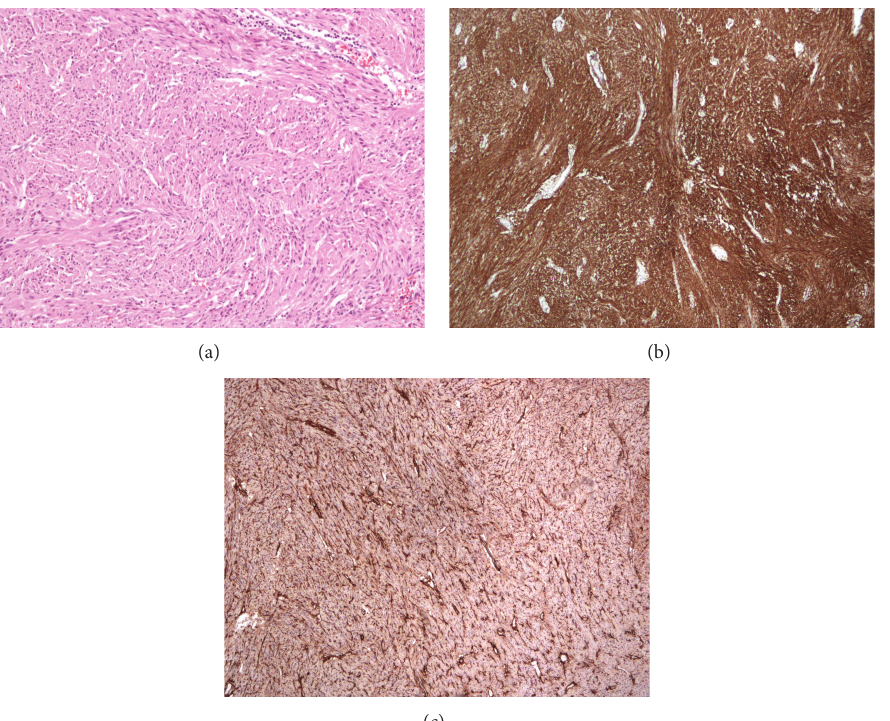
Figure 2: Immunohistochemistry at microscopic level of GIST neoplasm. (a) demonstrates the 10x image with hematoxylin and eosin staining. The tumour had a mitotic index of 2/50 high power fields (HPF). (b) shows positive staining for CD117 (c-kit) which is characteristic of GIST tumours and (c) shows the tumour also staining positive for CD34.